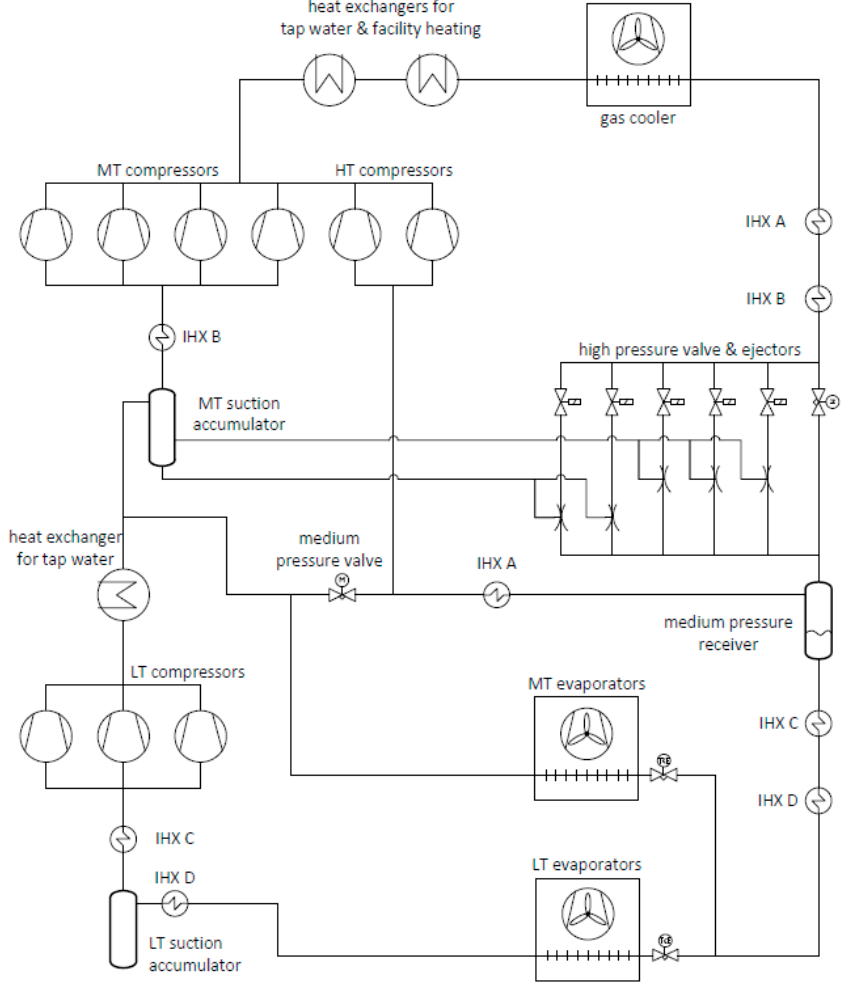
Figure 5. Schematic of a transcritical R744 booster supermarket refrigeration system outfitted with multi-ejector module and having both MT and LT overfed evaporators [37].